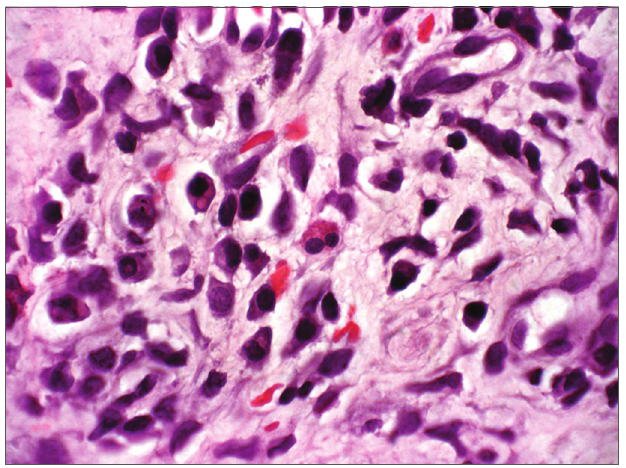
Figura 2. Rinite crônica agudizada - Lâmina com aumento de 1000x, coloração de Hematoxilina Eosina - Lâmina evidencia a presença de eosinófilos (célula binucleada ao centro da lâmina)